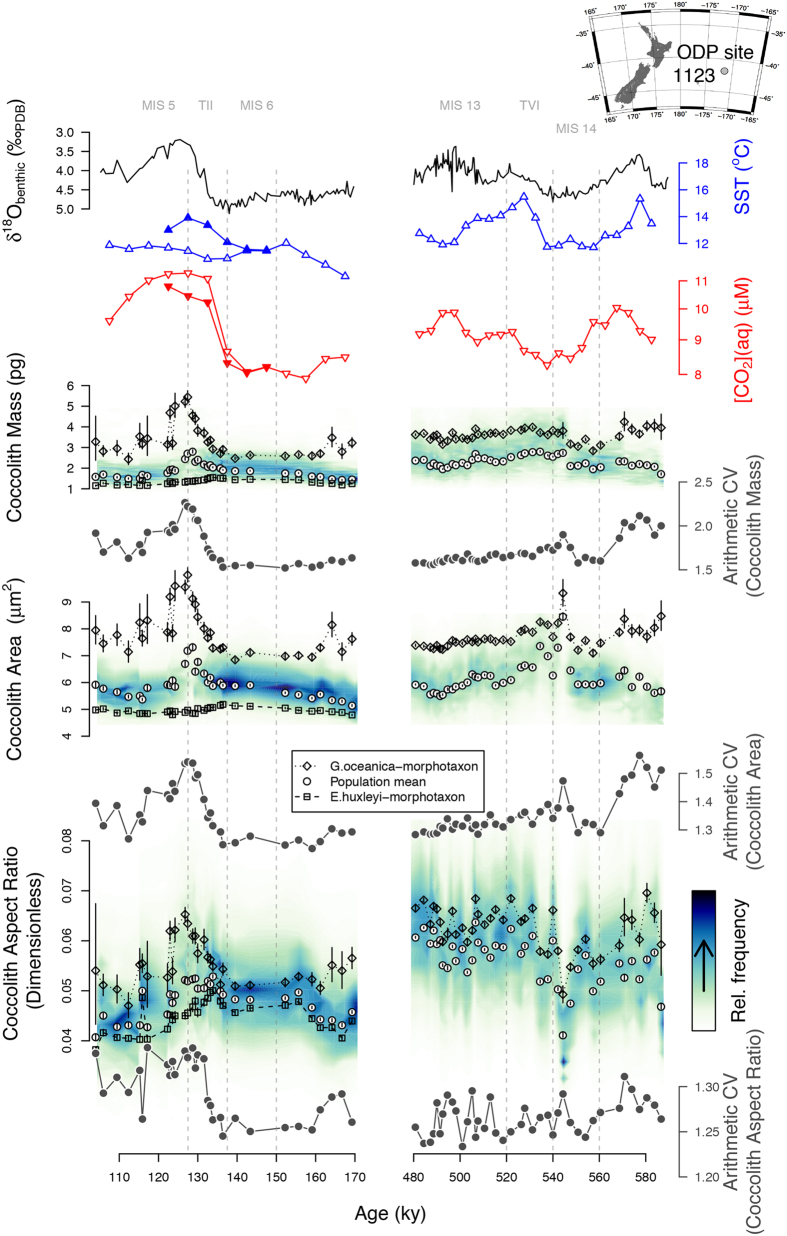
Calcification response of the Noëlaerhabdaceae to environmental changes over two glacial-interglacial cycles.(A) benthic δ18O49, and 5kyr interval average sea-surface temperature (from Mg/Ca ratios in planktic forams; filled triangles over TII represent an alternative size fraction - see methods) and [CO2(aq)] (calculated from CO2 atm52 and SST) at ODP site 1123 in the southern Pacific Ocean. (B–D) Coccolith morphometrics: (B) Mass, (C) Area and (D) Aspect ratio. Raw data are displayed as frequency-density contour plots. Emiliania huxley-affiliated morphotaxa (MGEmi) are hollow squares, Gephyrocapsa spp.-affiliated morphotaxa (MGGeo) are hollow diamonds and filled circles (population mean) represent the mean of the Noëlaerhabdaceae-affiliated morphotaxa in each sample. Arithmetic coefficient of variation (CV) is a measure of the mean-independent variance of log-normal data, and is shown in grey. Map was made using GMT 5.2.1 (http://gmt.soest.hawaii.edu/)58.